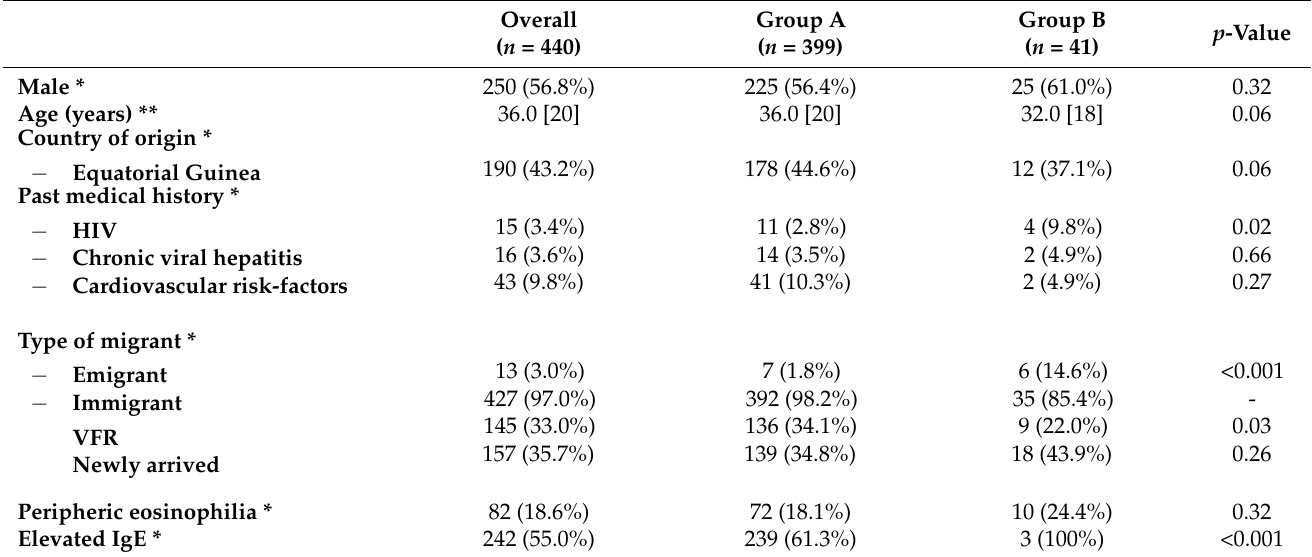
Table 1. Baseline characteristics in the overall cohort and by screening strategy.